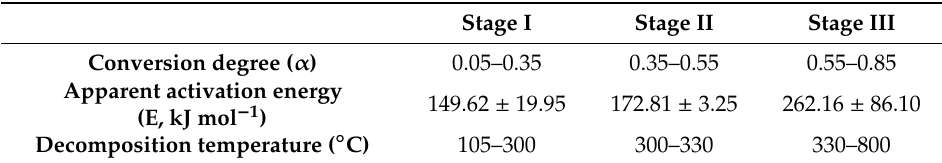
Table 6. Kinetic characteristics of pyrolysis stages